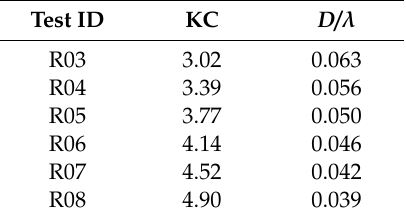
Table 3. Test IDs and values of KC and D / λ , characterizing the experimental conditions.